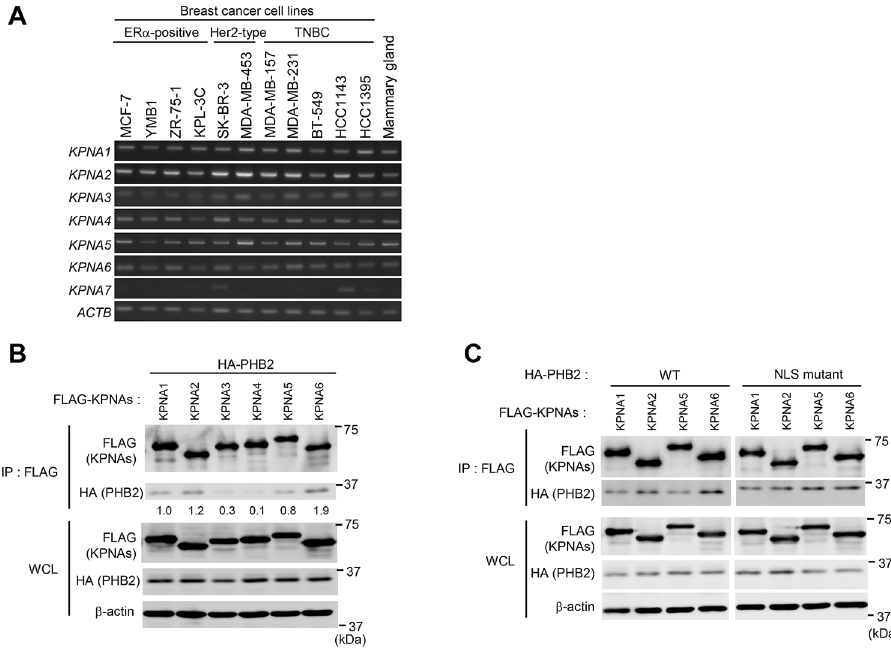
Fig 1. PHB2 interact with KPNAs. (A) The expression levels of the KPNA family of proteins in breast cancer cell lines and normal human mammary gland tissue were evaluated using semi-quantitative RT-PCR. ACTB is used as an internal control; (B, C) Immunoblotting analysis was performed to assess the interactions between PHB2 (B) or PHB2 NLS mutants (C) and each KPNA. The lysates from COS-7 cells transfected with PHB2 or PHB2 NLS mutants and each KPNA were immunoprecipitated with anti-FLAG antibody. Full-length images of immunoblots and semi-quantitative RT-PCR are shown in S1A – S1C Fig The data are expressed the fold increase over HA-PHB2 which bound to KPNA1 (set at 1.0)